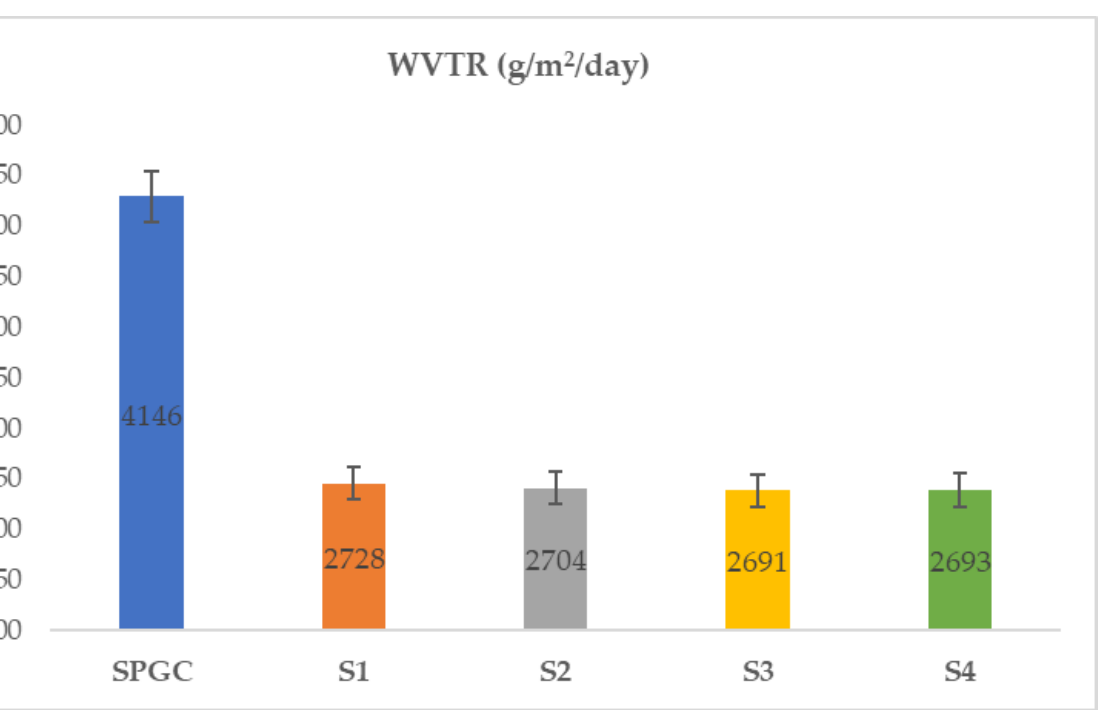
Figure 3. Biodegradable starch/PVA wound dressings’ WVTR before (SPGC) and after adding nano-ZnO particles (S1–S4) to the starch-based/polyvinyl alcohol composite.